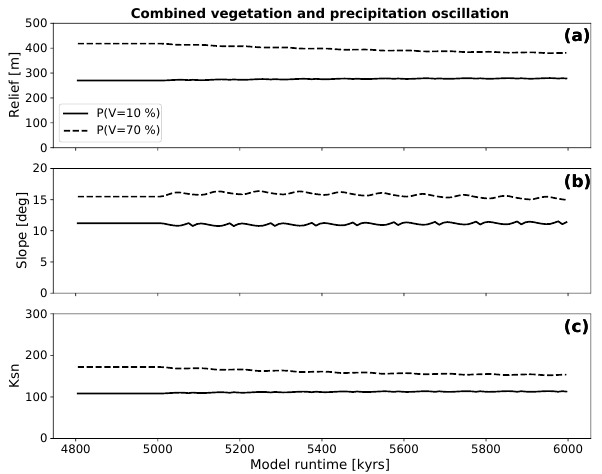
Figure 15. Evolution of topographic metrics for coupled simula- tions where both changes in surface vegetation cover and a corre- sponding change in mean annual precipitation (Fig. 5) are simul- taneously imposed. The amplitudes and frequency of the forcings that were imposed on the simulations are the same as those used for the simulations with isolated transient forcings. Panels (a) , (b) , and (c) show the evolution of the mean basin relief, the mean basin slope, and the mean basin channel steepness ( K sn ) after the start of the oscillation at 5Ma. Note the muted/damped response relative to previous simulations of oscillating vegetation cover or precipitation conditions.